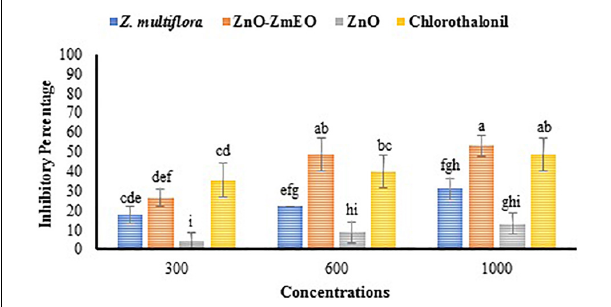
FIGURE 5 | Comparison of mean inhibitory percentage of ZnO, ZnO-ZmEO, pure Z. multiflora EO, and chlorothalonil on early blight